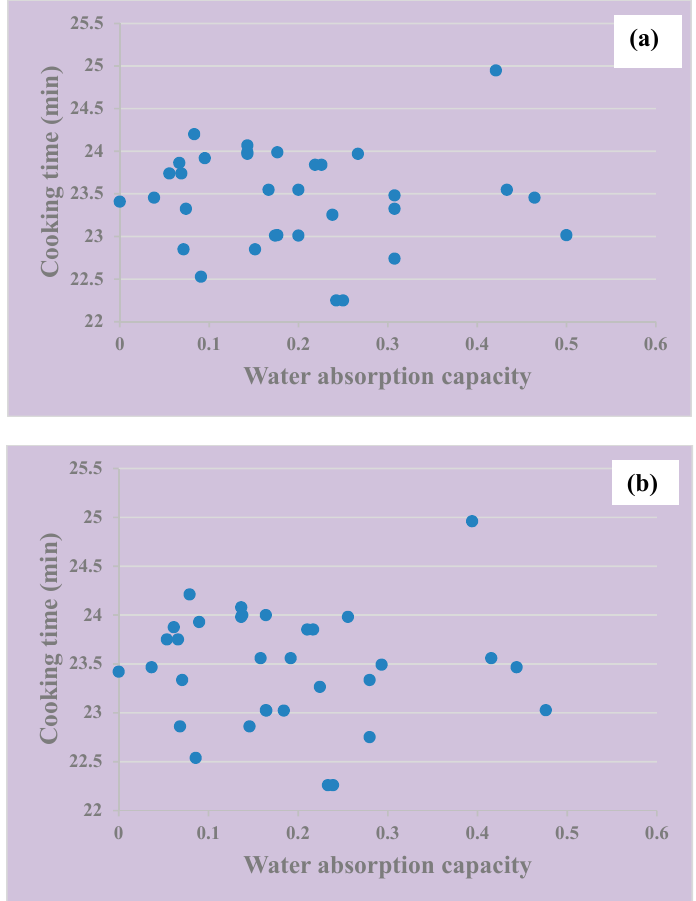
Figure 3. Correlation between water absorption and cooking time for the Vigna ambacensis accessions. ( a ) Plotted with data from Site A; ( b ) plotted with data from Site B.